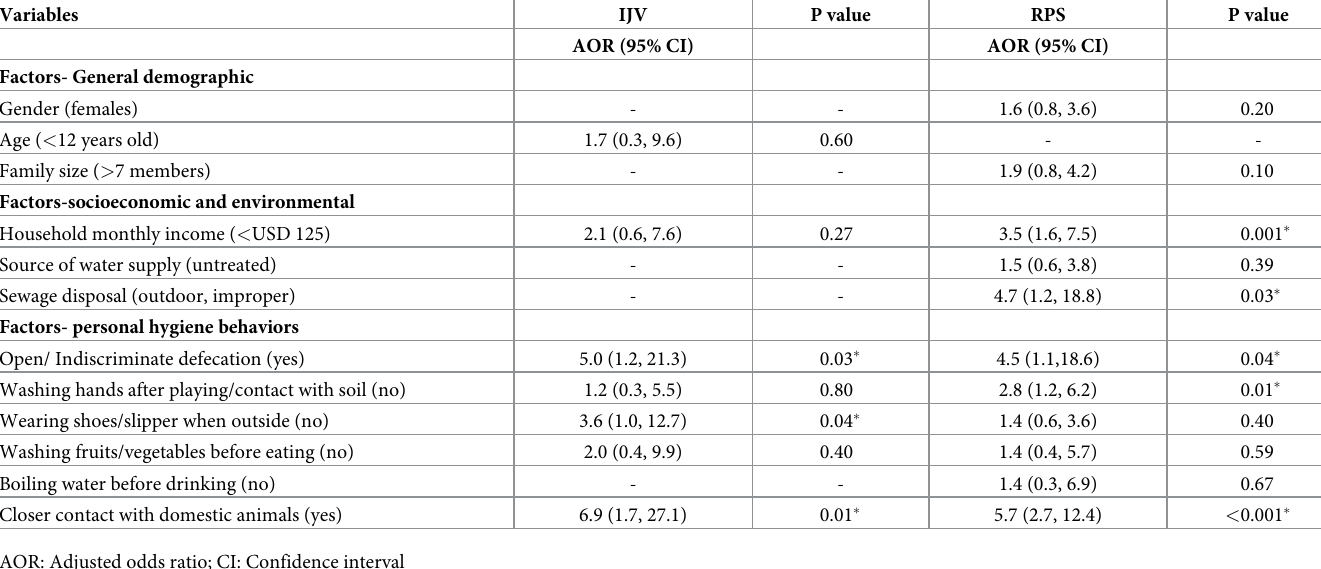
Table 6. Potential risk factors associated with STH infections among IJV and RPS communities (multivariate logistic regression